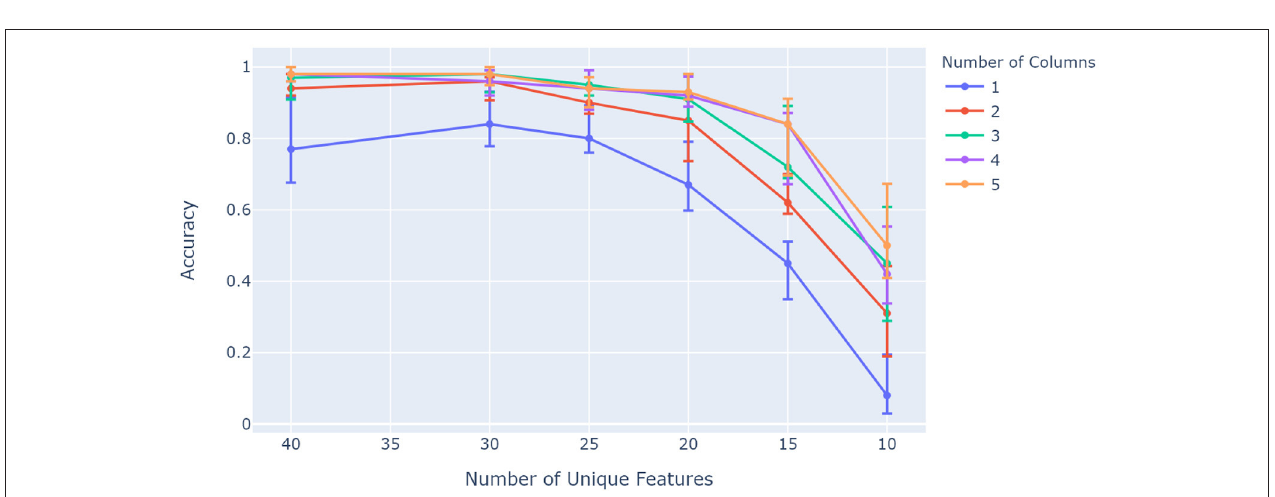
FIGURE 7 | Comparison between different numbers of columns over a range of unique feature pool sizes. More columns retain better accuracy as object ambiguity increases (object uniqueness decreases). The network was configured to have 25 modules and 13 cells per axis, and was trained on 50 objects with 10 features each. The experiment was repeated 10 times, with the 5th, 50th, and 95th percentiles